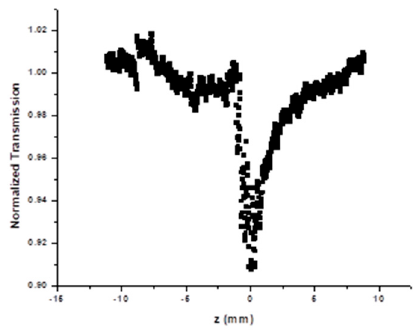
Figure 8. Normalized transmission (open aperture) for colloidal AgNPs, S0 at 514 nm. The transmission peak is symmetric with respect to the focus (z = 0), where the value is minimum. This demonstrates the reverse saturation absorption (RSA) characteristic of silver nanoparticles. The RSA is a positive nonlinear absorption effect, and this feature was also observed at a wavelength of 488